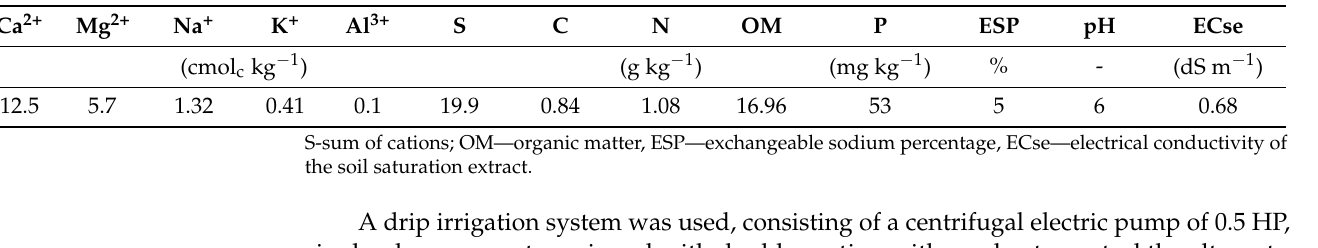
Table 1. Chemical analysis of the soil (0–20 cm depth) of the experimental area in the municipality of Russas, Ceará, Brazil.